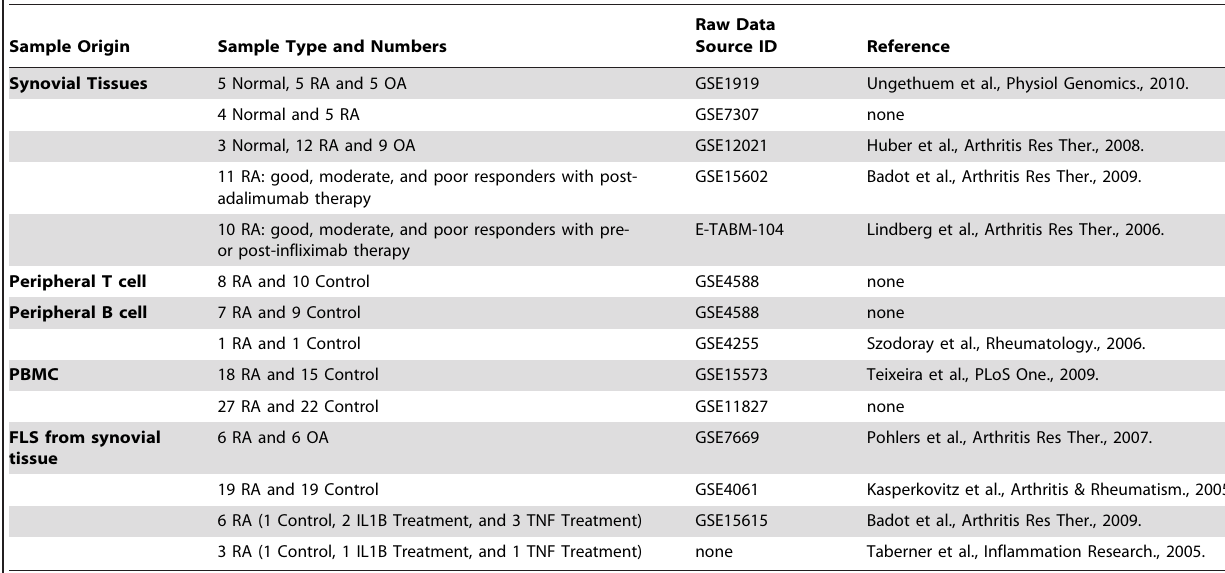
Table 1. 14 gene expression datasets used in this